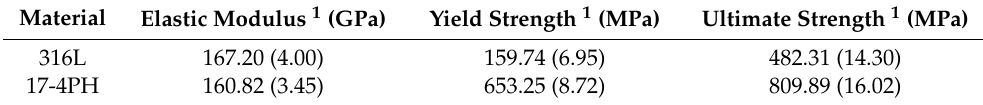
Table 3. The mechanical properties of 316L and 17-4PH stainless steel full-solid specimens.